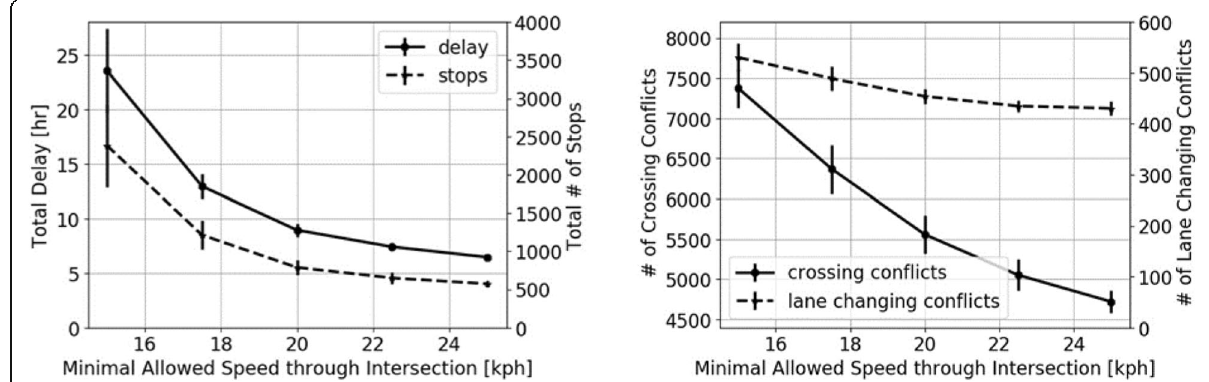
Fig. 6 Impact of cell-crossing speed on delays, stops and conflicts